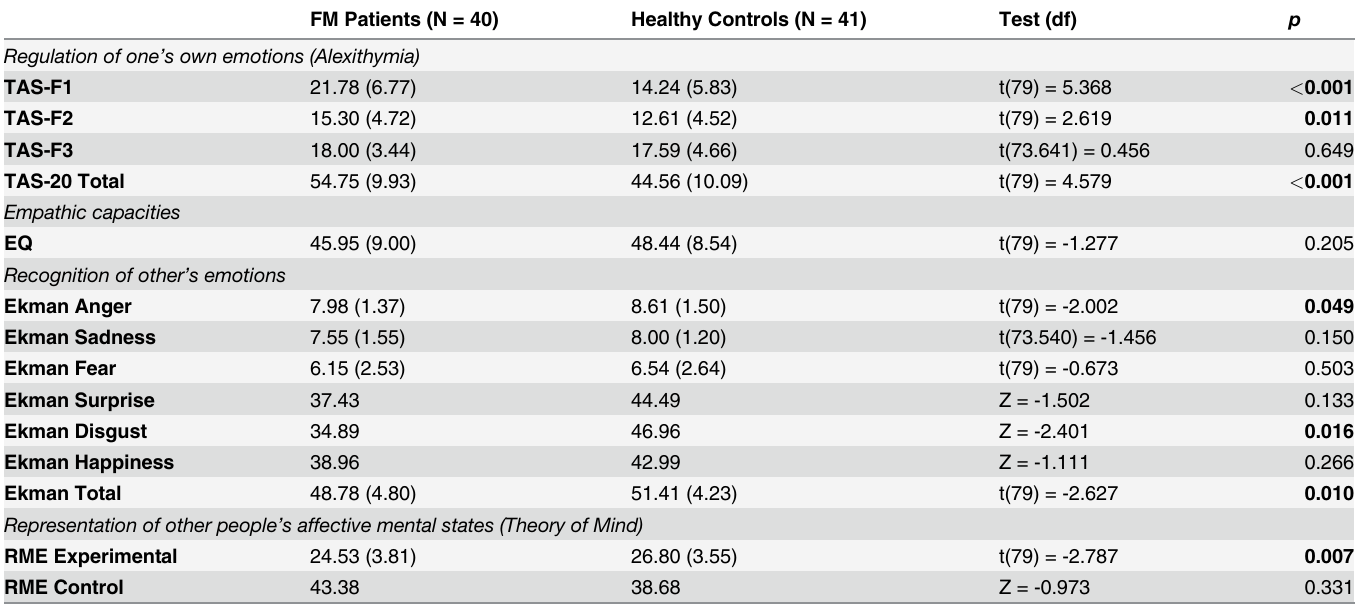
Table 4. Theory of Mind and emotional functioning measures